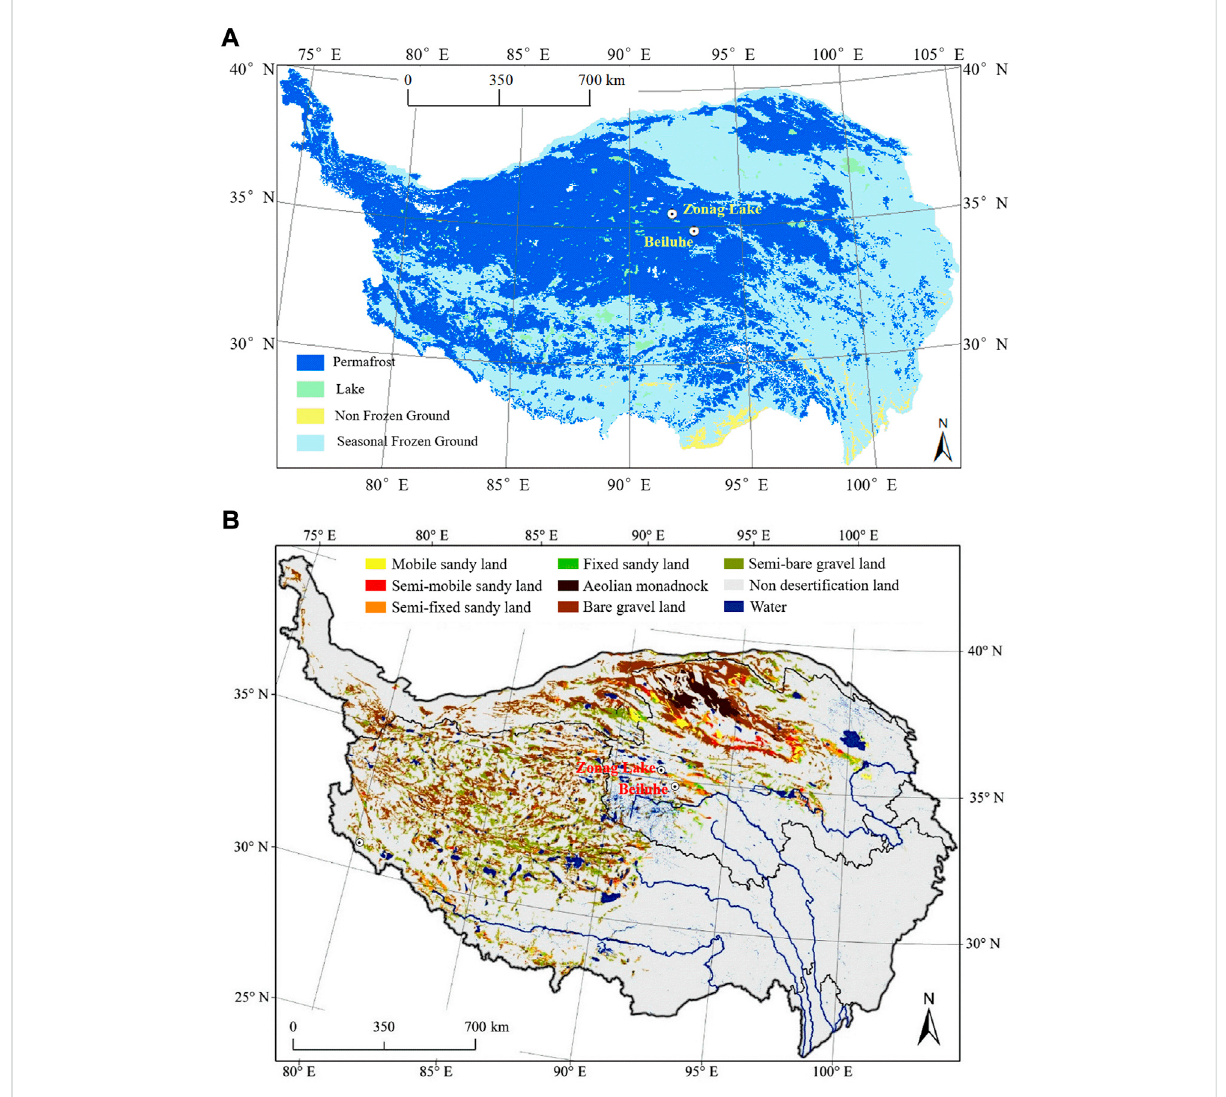
FIGURE 1 (A) Permafrost distribution and (B) Aeolian deserti fi ed land distribution on the Qinghai-Tibetan Plateau (Zhang et al.,